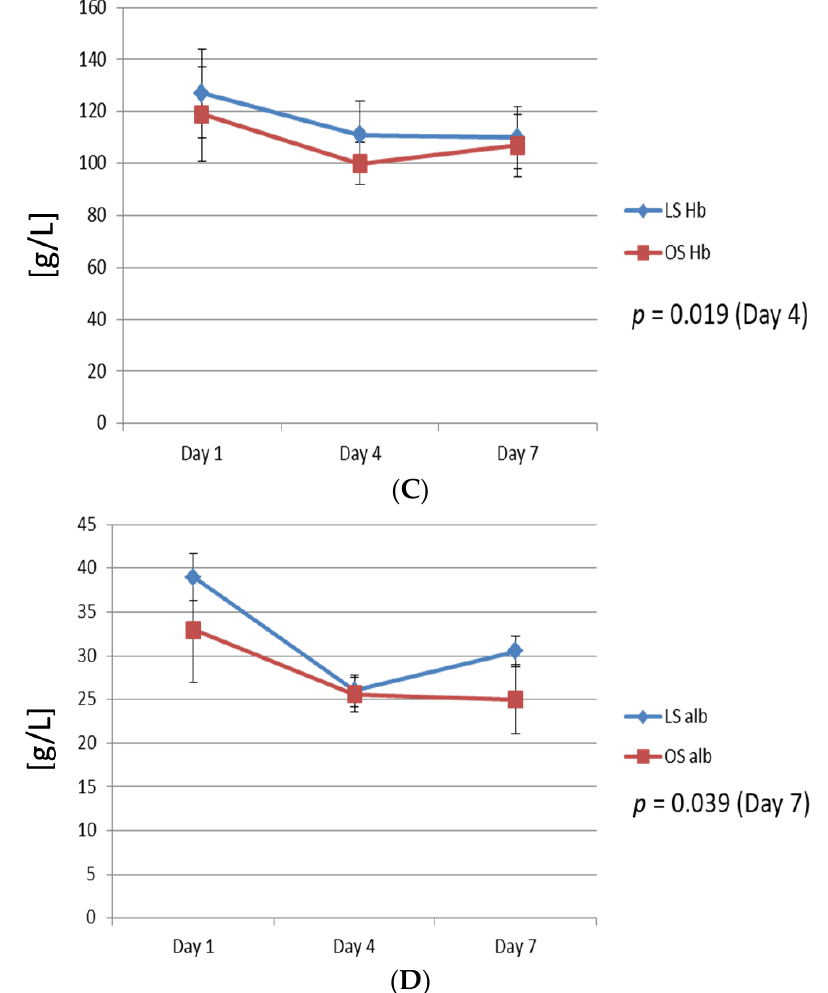
Figure 2. Postoperative dynamics of serum leptin, CRP, haemoglobin, and albumin between groups in the subgroup of patients with serum CRP < 100 mg/L. ( A ) Postoperative dynamics of serum leptin concentrations. * Serum levels of leptin on day seven were significantly lower in the LS group. ( B ) Postoperative dynamics of serum CRP. ( C ) Postoperative dynamics of serum haemoglobin. ( D ) Postoperative dynamics of serum albumin. LS: laparoscopic surgery; OS: open surgery.